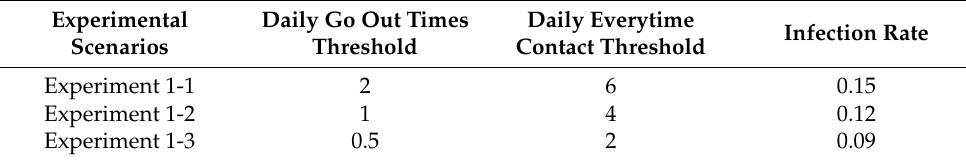
Table 2. Basic experiments based on three kinds of going out needs.